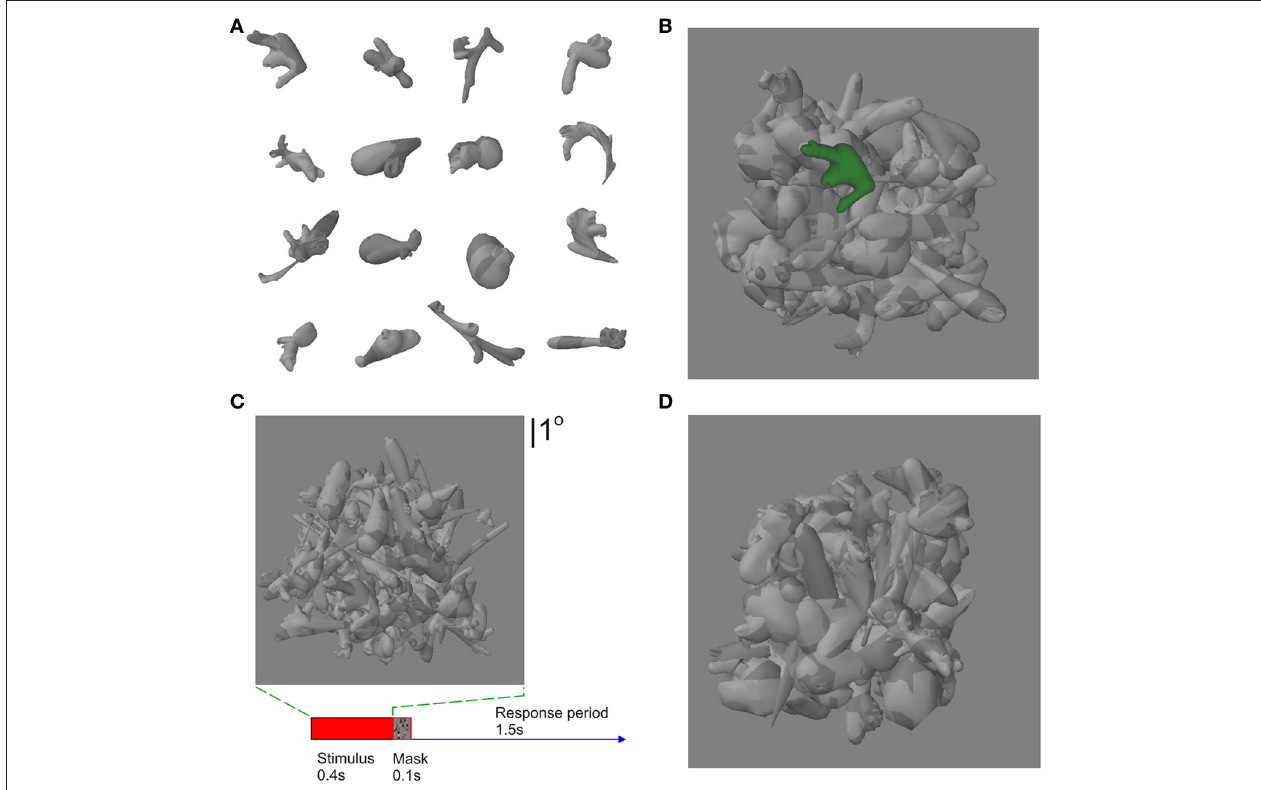
counterbalanced among subjects. (D) The recognition task performed by the subjects during fMRI scans. The target object wasalwayspresented in the presence of clutter during the scans, regardless of whether agiven object was learned with or without clutter during training. Subjects were required to report whether the stimulus contained a learned target or not, regardless of the location of the target. The panels in this figure are not drawn to the same